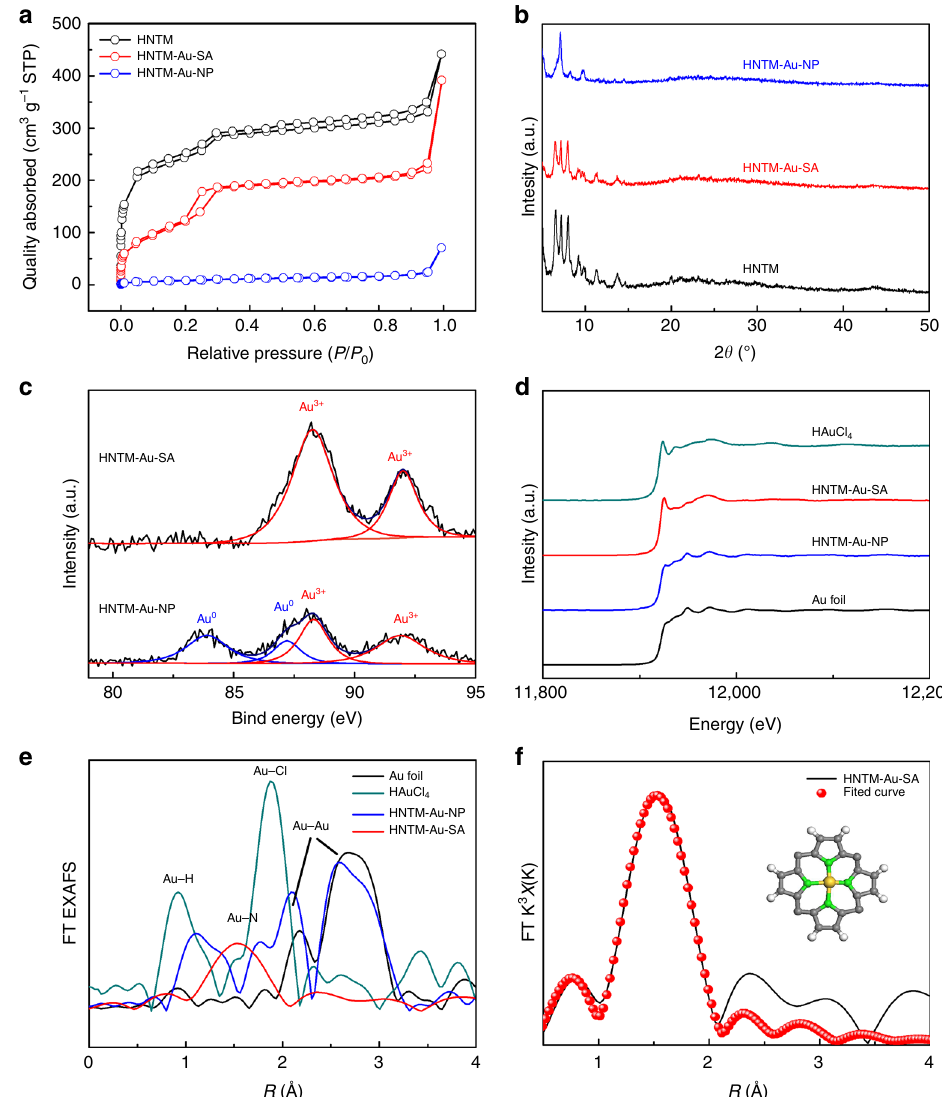
Fig. 2 Single-Au-atom structure characterization. a Nitrogen adsorption – desorption isotherms and b XRD curves of HNTM, HNTM-Au-SA, and HNTM-Au- NP. c Au 4 f XPS spectra of HNTM-Au-SA and HNTM-M-NP. d The normalized XANES spectra. e FT-EXAFS spectra of HNTM-Au-SA, HNTM-Au-NP, HAuCl 4 , and Au foil at Au L3 edge. f The FT-EXAFS space- fi tting curve of HNTM-Au-SA. Inset shows schematic models of HNTM-Au-SA, Au (yellow), N (green), C (gray), and H single-atom structure (Supplementary Fig. 11), indicating Co and